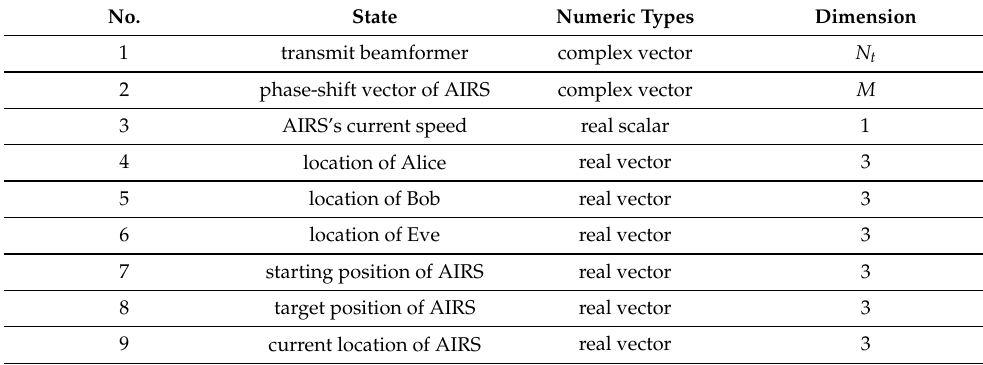
Table 2. Description of states in the DDPG algorithm.